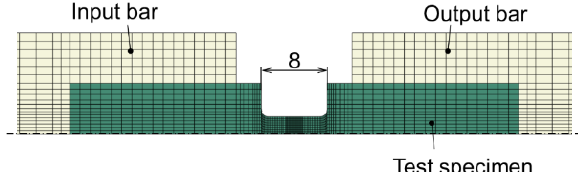
Fig. 4. FE mesh of SHB test simulation (unit: mm)